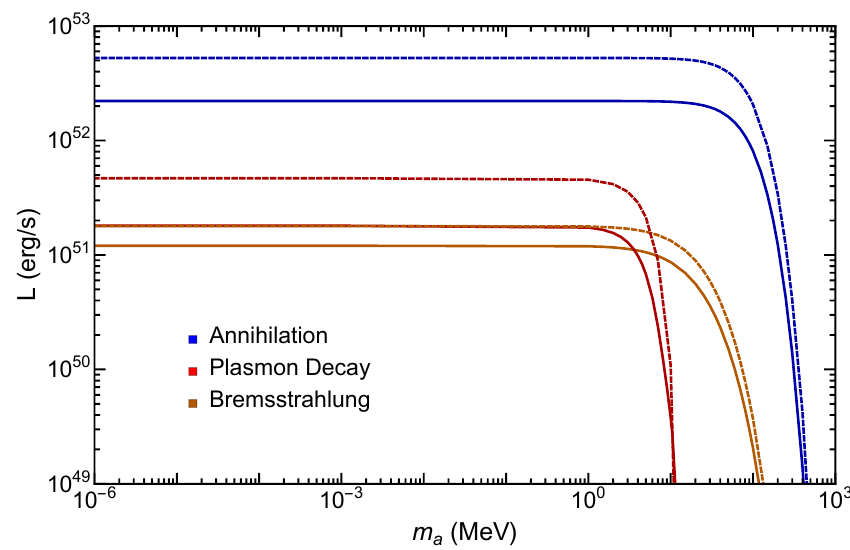
Figure 10 . The total luminosity of various channels as a function of axion mass. The solid lines show the profile in ref. [57] while the dashed lines show the profile in ref. [63]. The difference in the bounds on f a is about a factor of